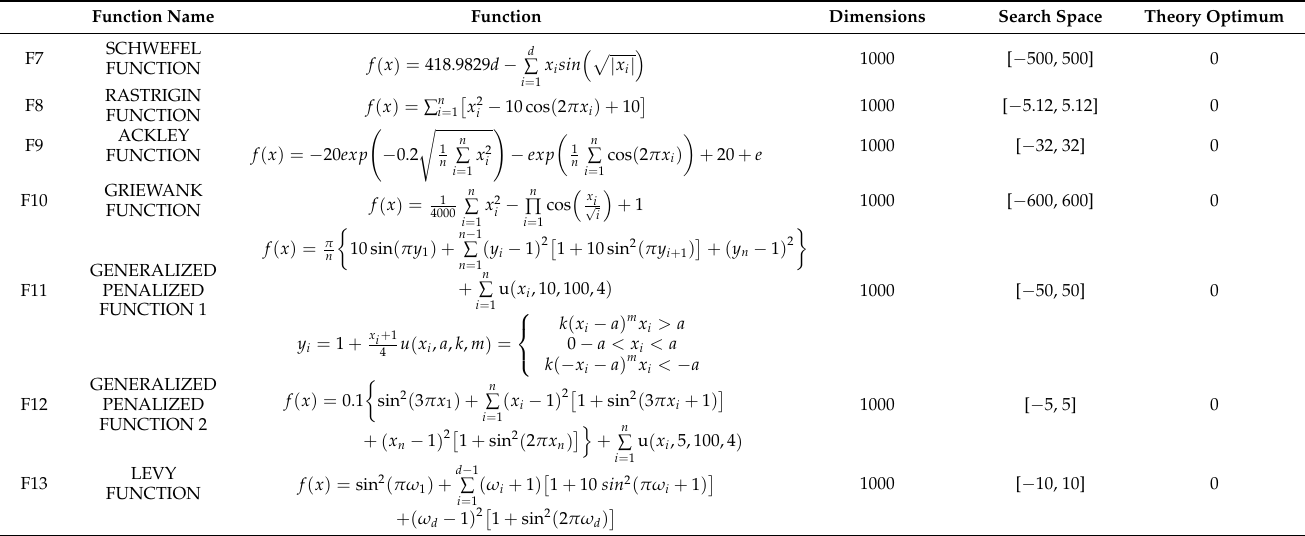
Table 2. High-dimensional unimodal benchmark test